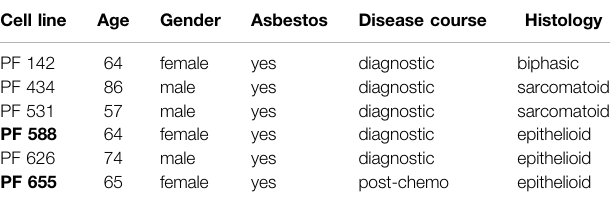
TABLE 1 | Patient characteristics of the newly established MPM cell lines. PF588 and PF655 cell lines (in bold) are derived from the same patient. Cell